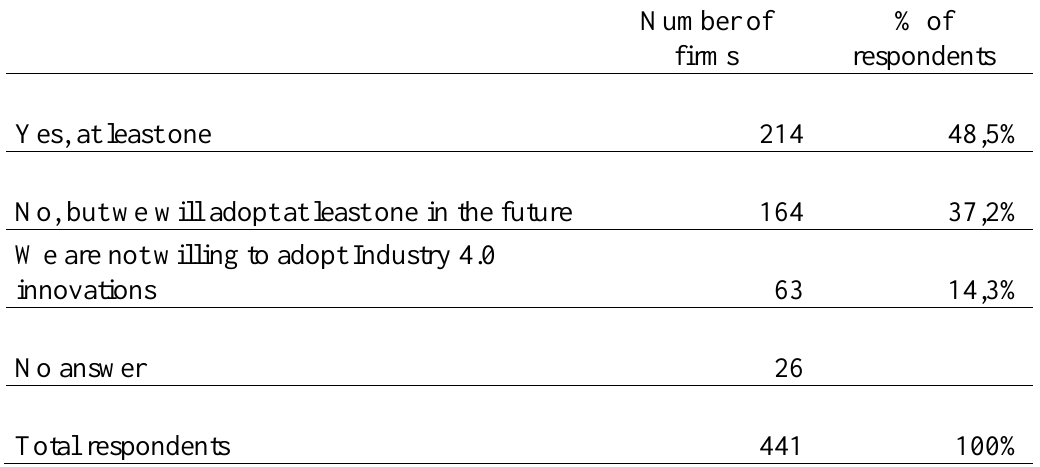
Have you Adopted Or Are You Willing to Adopt Innovative Industry 4.0